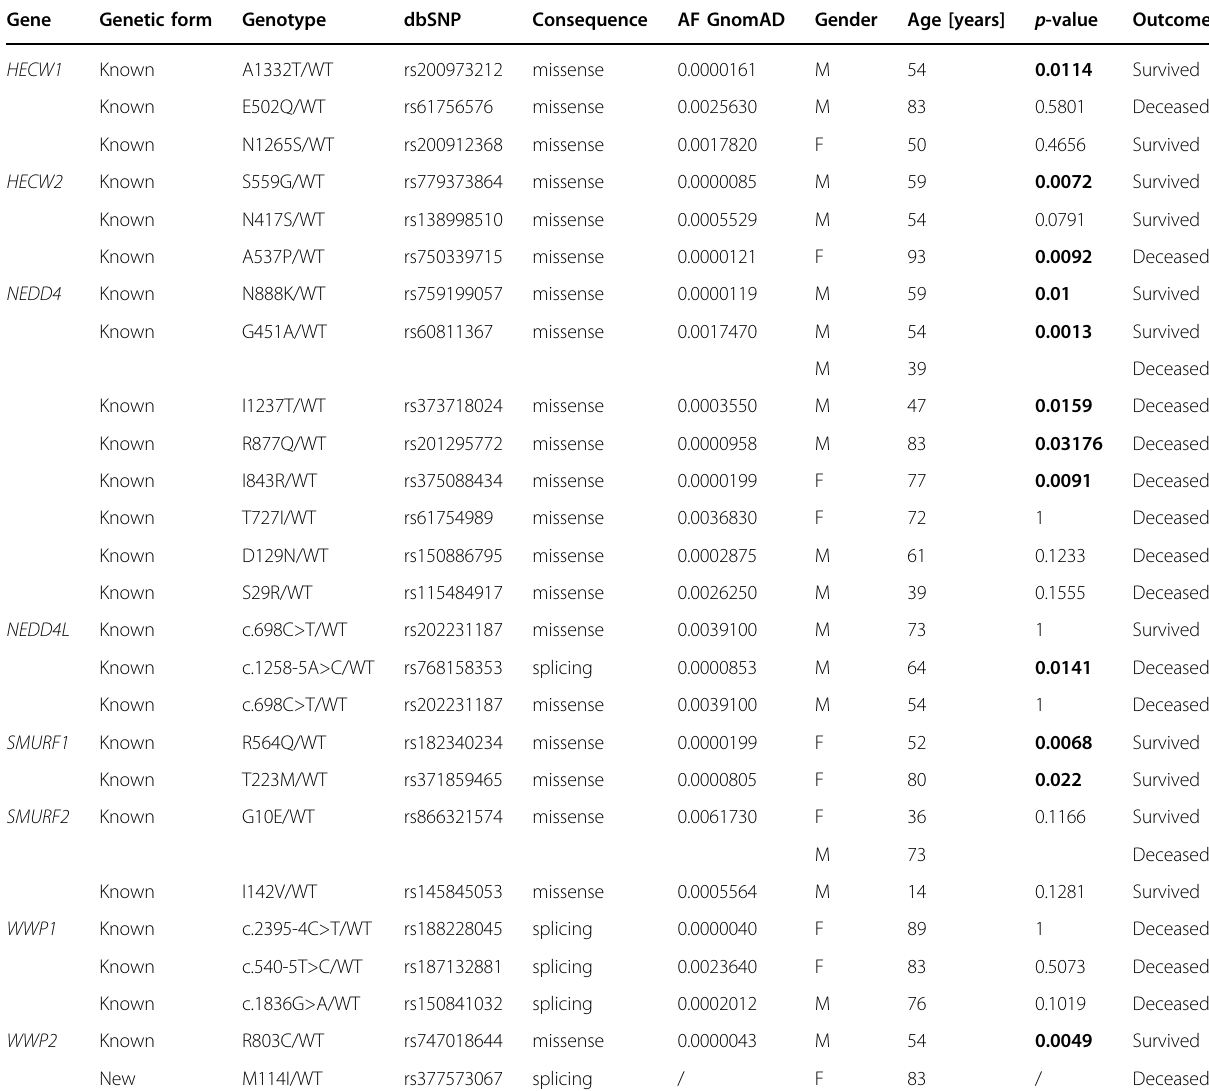
Table 1 HECT genes variants in a cohort of 130 SARS-CoV-2 positive patients (MAF < 0.01 in GnomAD v2.1.1; in bold p <